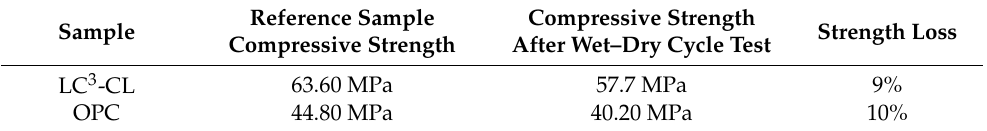
Figure 2. Compressive strength results for OPC and LC 3 -CL subjected to sulfate attack. Both the OPC and LC 3 samples that were subjected to wet–dry cycles exhibited the lowest strength in all three sets. The percentage loss of strength is shown in Table 3. Sulfate salts usually degrade porous structures by either physical or chemical processes. The loss in strength in both OPC and LC 3 samples can be attributed to both physical and chemical sulfate attacks. Table 3. Strength loss after wet–dry cycle test.